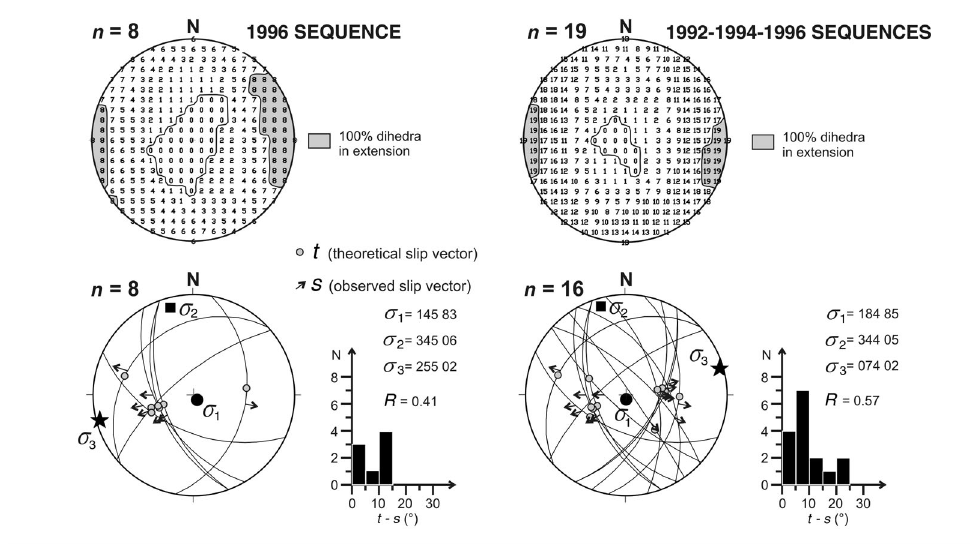
Fig. 5. Stress analysis of the focal mechanisms of 1996 ( left ) and combined 1992, 1994, 1996 ( right ) sequences. Top : superposition of extensional dihedra (containing T -axes); small numbers indicate the number of dihedra com- mon to each point of the grid (Schmidt projection). Bottom : preferred seismic planes (Wulff projection), observed and theoretical slip vectors, parameters of the stress ellipsoid obtained by inversion and histogram of the angular divergence between theoretical ( t ) and observed ( s ) slip vectors. Stress axes are indicated as trend (first three num- bers) and plunge (last two numbers); R (shape factor) gives the value of the stress ratio ( σ